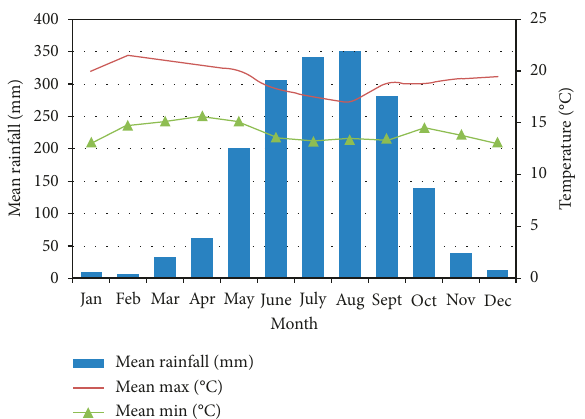
Figure 2: Mean monthly rainfall (mm), minimum, and maximum temperatures ( ° C) of the study area recorded for the year from 2006 to 2015. Source: National Meteorological Agency; Gida Ayana Meteorological